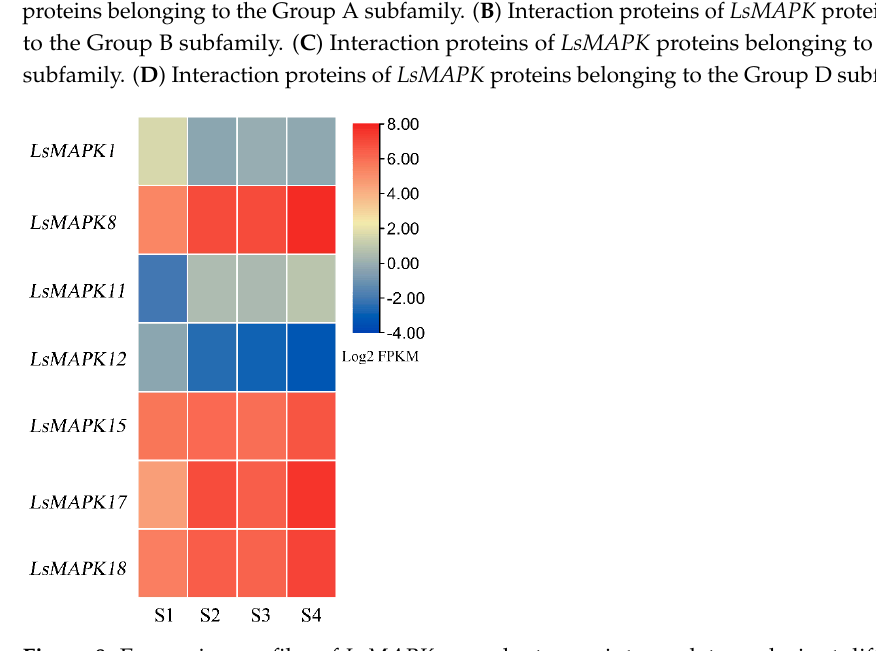
Figure 8. Expression profiles of LsMAPK genes by transcriptome data analysis at different lettuce stem enlargement periods. S1: diameter length is 1 cm; S2: diameter length is 2 cm; S3: diameter length is 3 cm; S4: diameter length is 4 cm. Different color represented different expression levels of LsMAPK genes identified by RNA-Seq.